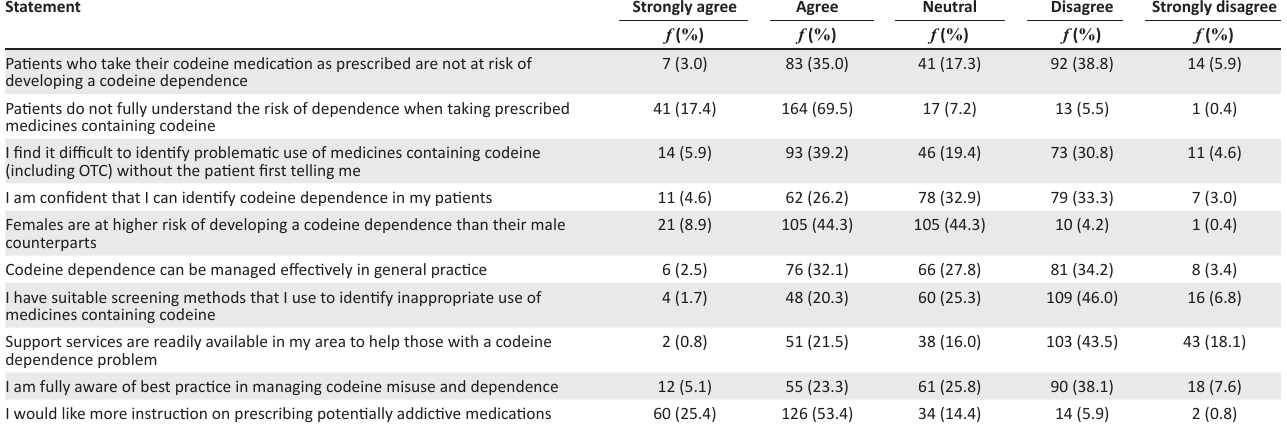
TABLE 4: Level of agreement, disagreement and neutral responses with statement items related to codeine dependence and